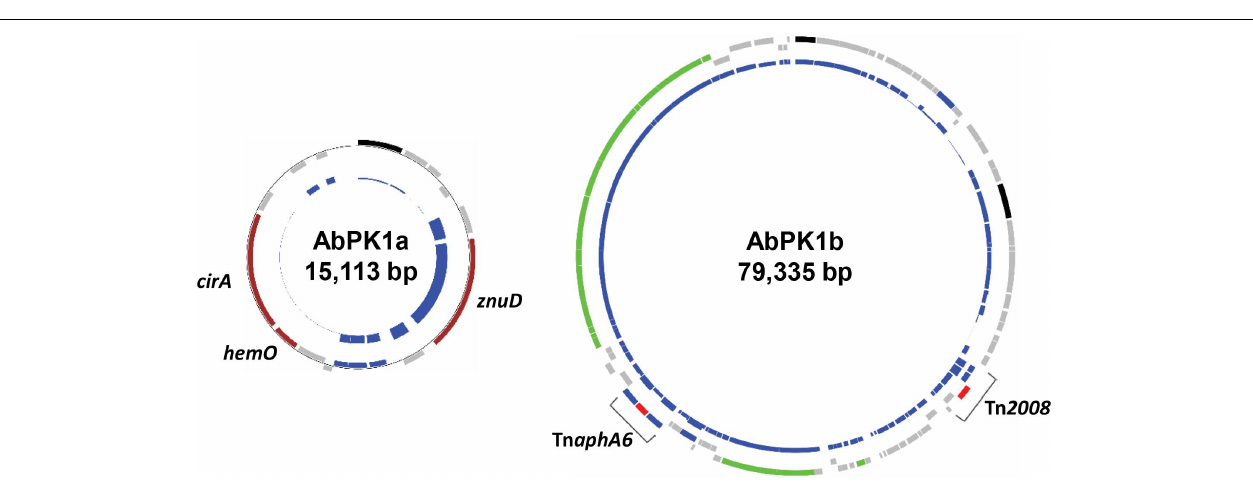
FIGURE 5 | Plasmids in strain AbPK1 containing iron acquisition genes (AbPK1a), transposons and a conjugation gene cluster (AbPK1b). Outer circles: protein-encoding genes in forward (outer rectangles) and reverse (inner rectangles) orientation color-coded by function; brown – iron acquisition; gray – hypothetical protein; black – plasmid replication; green – conjugation; blue – IS elements; red – antibiotic resistance. Inner circles: Relative frequency of gene presence in 2283 sequenced A. baumannii isolates. While the znuD gene was present in 56% of the analyzed genomes, cirA and hemO were found in only 26 genomes